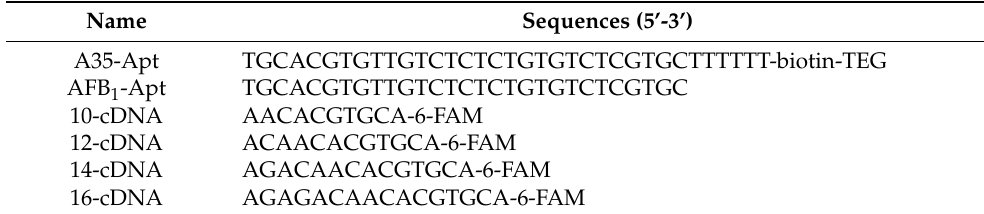
Table 5. Sequences of aptamer and